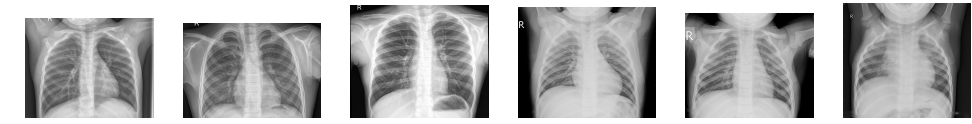
Figure 1. Examples of chest X-ray images of healthy people.